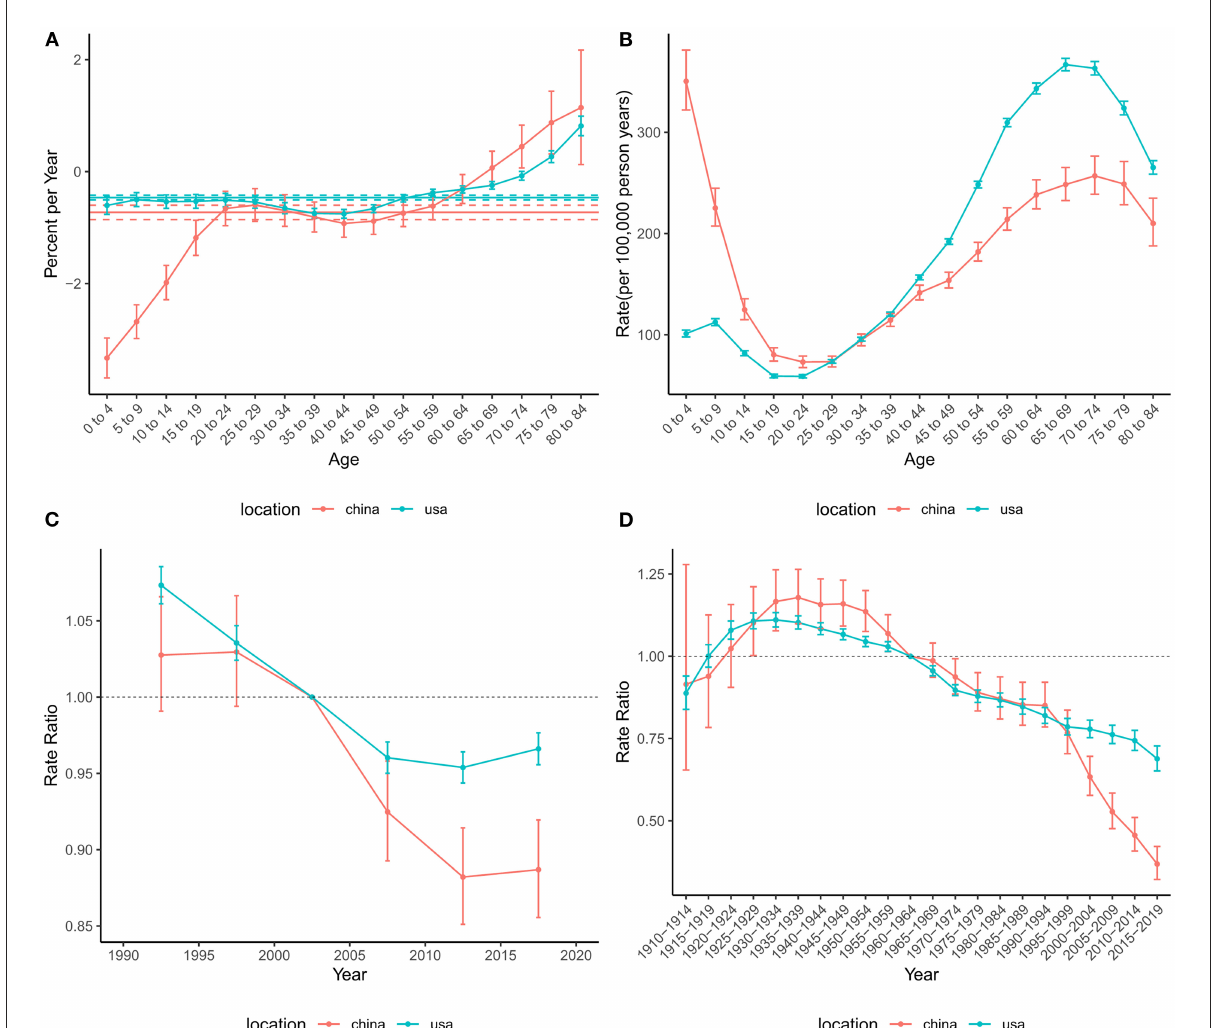
FIGURE5 Age-period-cohort effects on the DALYs rate of brain and CNS cancers in China and the US. (A) Net drift and local drift values for brain and CNS cancers DALYs rate in China and the US. (B) Longitudinal age curves for the DALYs of brain and CNS cancers in China and the US. (C) Period effects on the DALYs rate of brain and CNS in China and the US relative to the reference period (2000–2004). (D) Cohort effects on the DALYs rate of brain and CNS cancers in China and the US relative to the reference cohort (1960–1964). Vertical solid bars represent the 95% confidence intervals. DALYs, disability-adjusted life-years; CNS, central nervous